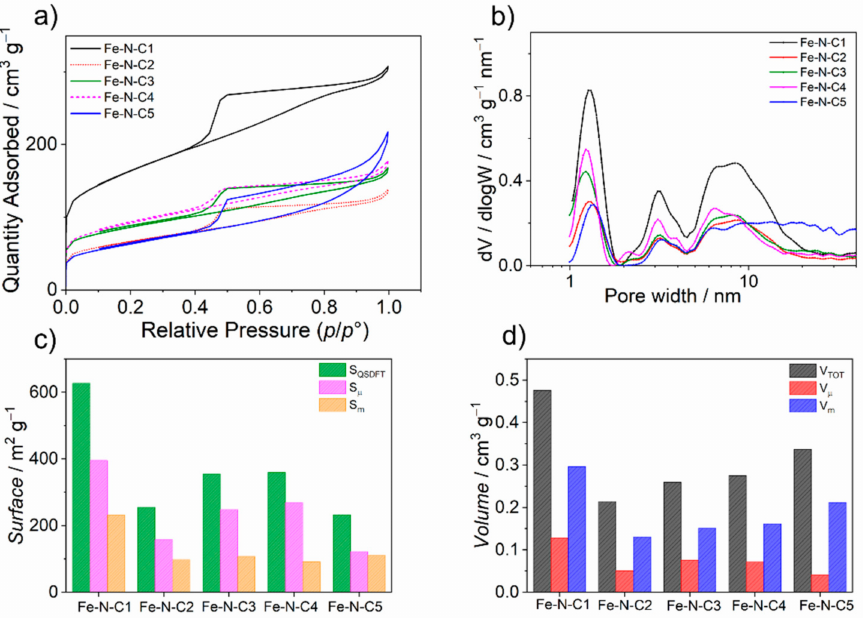
Figure 2. ( a ) N 2 adsorption/desorption isotherms and ( b ) pore size distribution of the investigated catalysts. Micro-, meso- and total ( c ) surface area and ( d ) pore